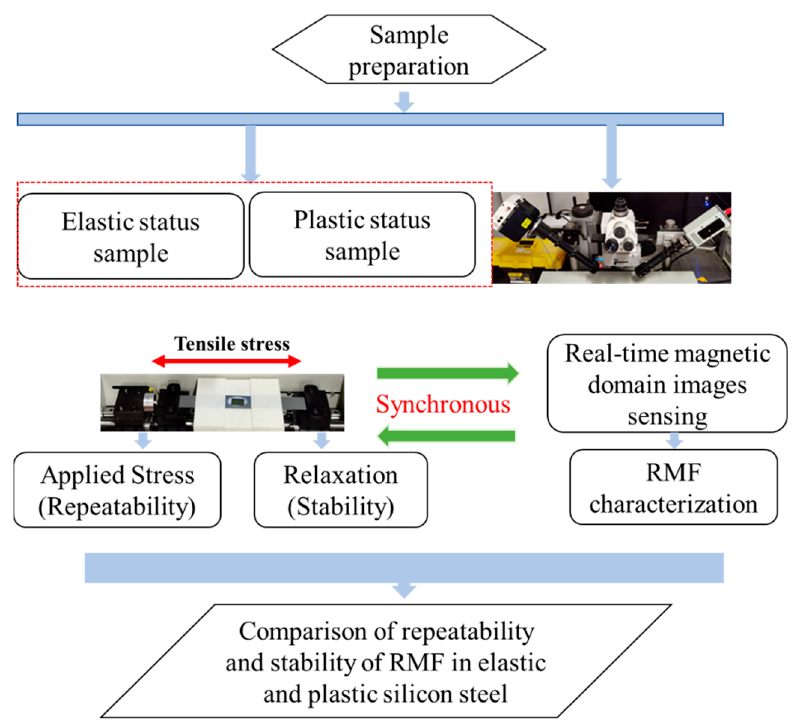
Figure 1. Schematic diagram of the